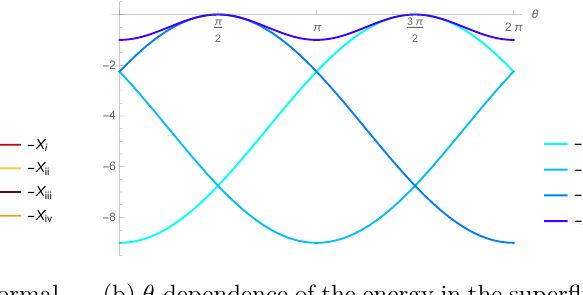
(b) θ -dependence of the energy in the superfluid phase for N = 3 . f